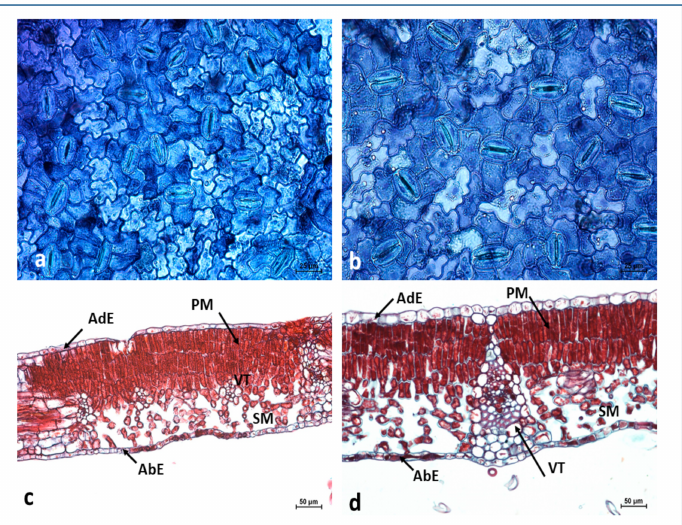
Figure 4. Stomata and leaf cross-section of diploid ( a , c ) and autotetraploid clone 4x-25 ( b , d ) of the apple cv. ‘Redchief’; AdE—adaxial epidermis, AbE—abaxial epidermis, PM—palisade mesophyll, SM—spongy mesophyll, VT—vascular tissue.